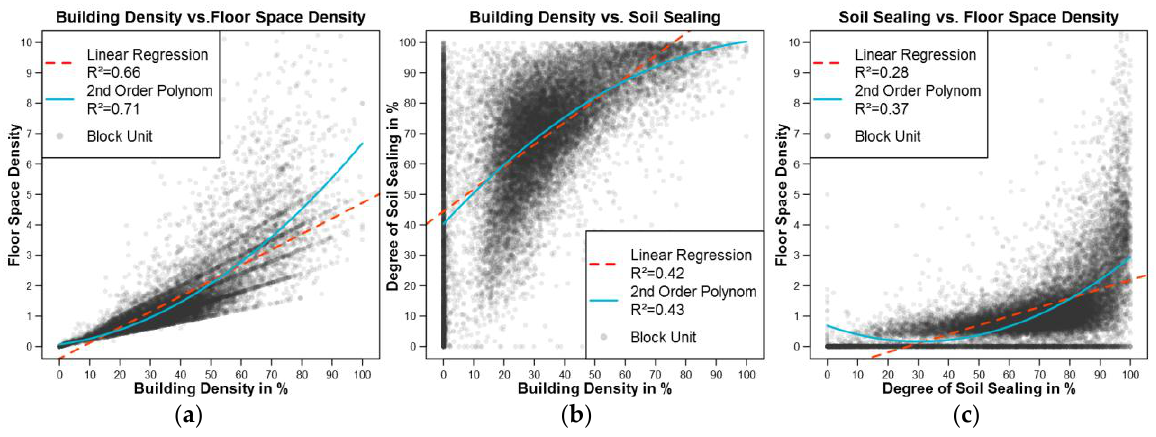
Figure 8. ( a ) Floor space density as function of building density; ( b ) Soil sealing as function of building density; and ( c ) Floor space density as function of soil sealing; all examples are presented at block level using gross densities for Paris.